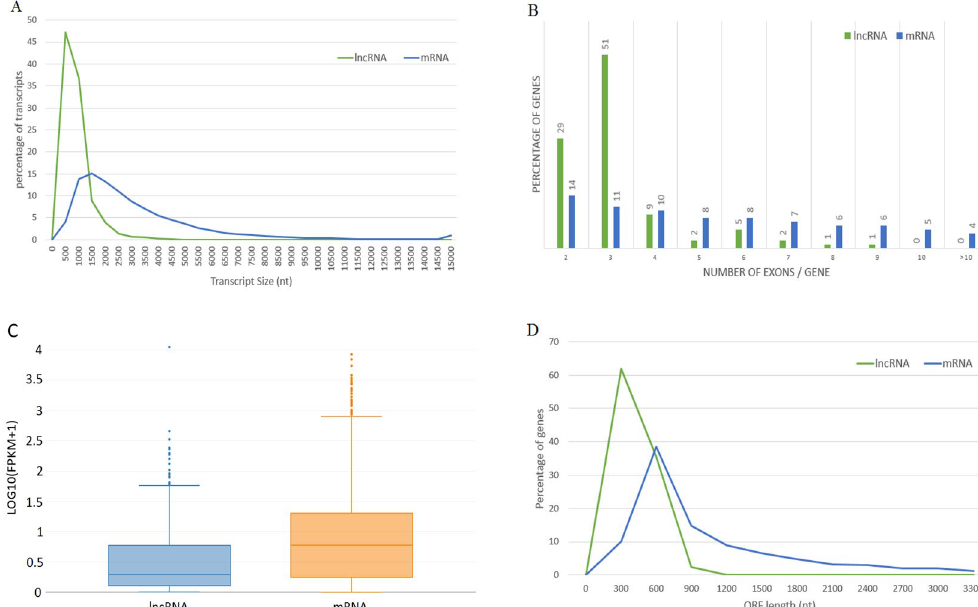
Figure 4. Comparison of expression and genomic features of predicted lncRNA and mRNA in Pashmina goat. The lncRNA and mRNA identified in this study are utilized to identify few primary differences between two classes. ( A ) Distribution of transcript length of long non-coding and coding transcripts in Pashmina goat skin. The X-axis/horizontal axis represents the length of transcripts and Y-axis/vertical axis represents percentage of genes. LncRNAs were shorter in length than mRNAs with 0.7 kb and 3 kb average length of each transcript, respectively. ( B ) Distribution of number of exons present in mRNA and lncRNA, most of lncRNA (80%) have 2 or 3 exons whereas mRNAs tend to have two or more exons. Due to the limitation of algorithms single-exon lncRNAs were filtered out from the goat genome. ( C ) Expression levels indicated by LOG10(FPKM + 1) in the mRNA and lncRNAs. ( D ) Represents distribution of ORF in mRNA and lncRNAs. LncRNAs have shorter ORF in length than mRNAs with a mean of 100 bp and 400 bp, for lncRNAs and mRNAs,